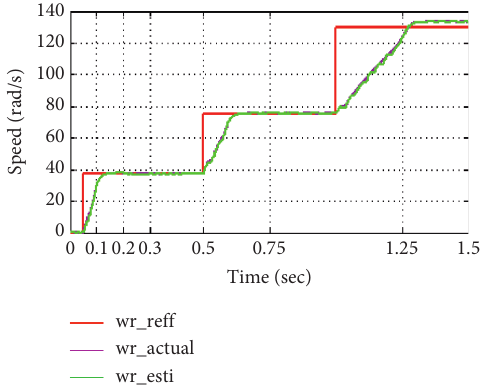
Figure 18: 50% increase of R rotor